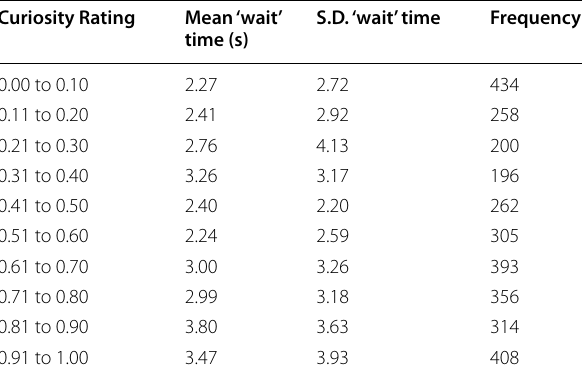
Table 1 Waiting Times by Curiosity Bin, Experiment